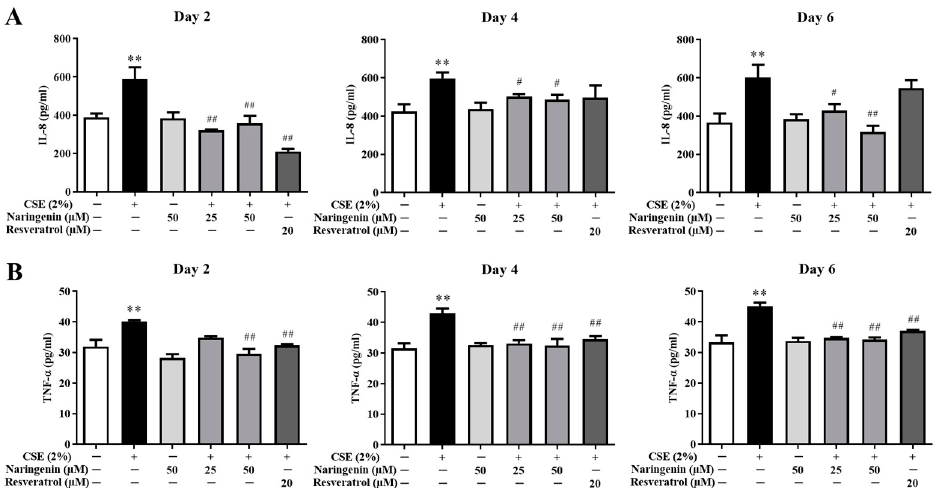
Figure 5. The effects of naringenin on CSE-induced IL-8 ( A ) and TNF- α ( B ) levels in BEAS-2B cells. Data are expressed as the means ± SD. ** p < 0.01 vs. Control group; # p < 0.05, ## p < 0.01 vs. CSE alone group.